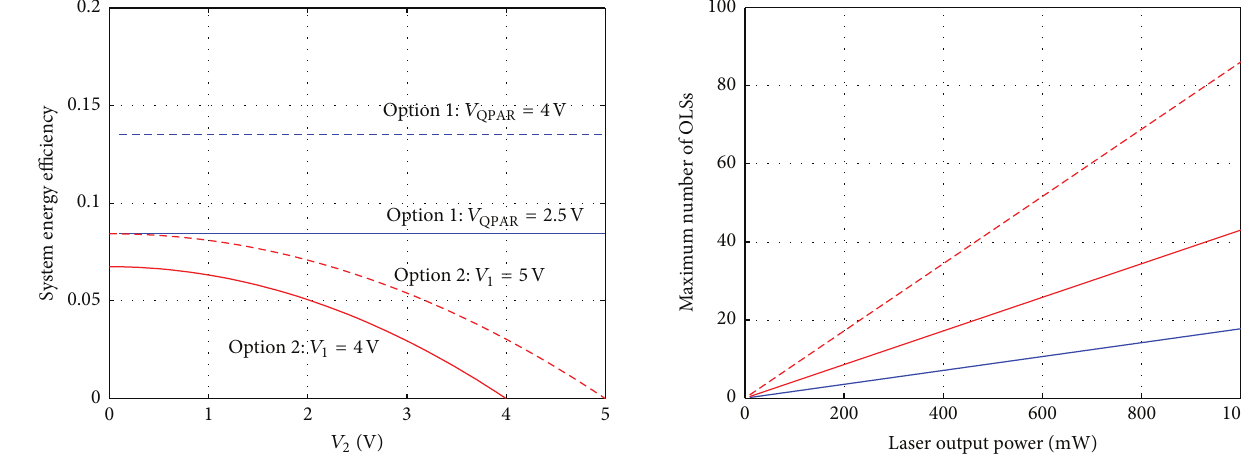
Figure 6: System Energy Efficiency (SEE).